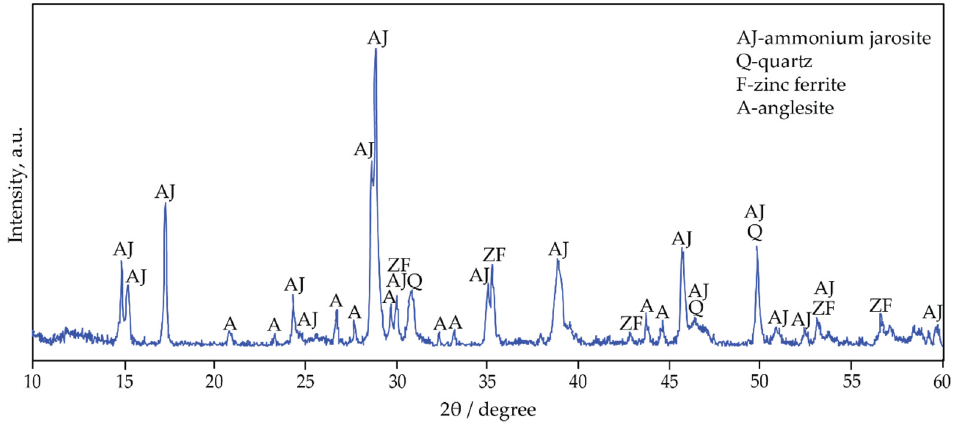
Figure 2. XRD pattern of jarosite-PbAg sludge.